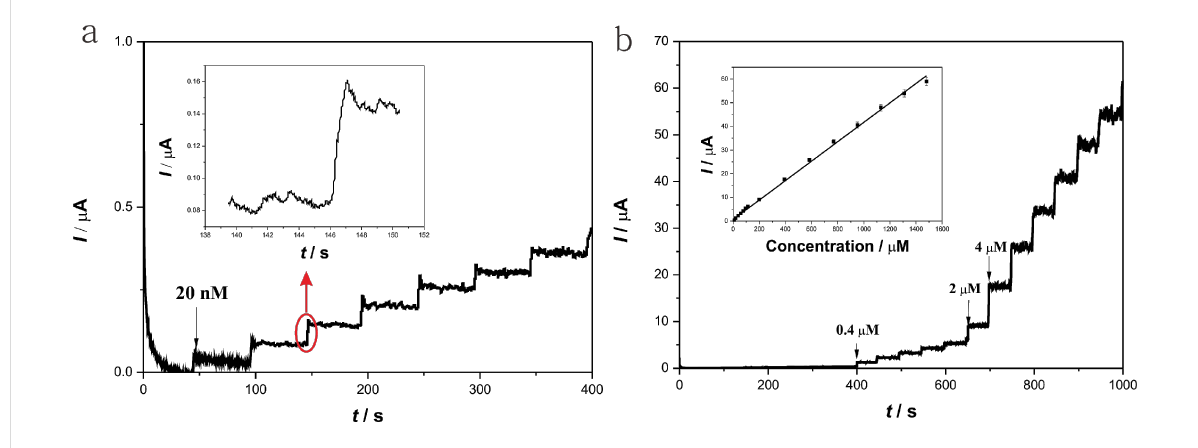
Figure 8: Typical steady-state current response of the laccase – Nafion–ECNFs/GCE on the successive addition of catechol solutions with different concentrations and volumes into 0.2 M acetate buffer (pH 5.5). Inset: A magnification of the third addition of catechol (a); The linear calibration curve of the current response on the catechol concentration